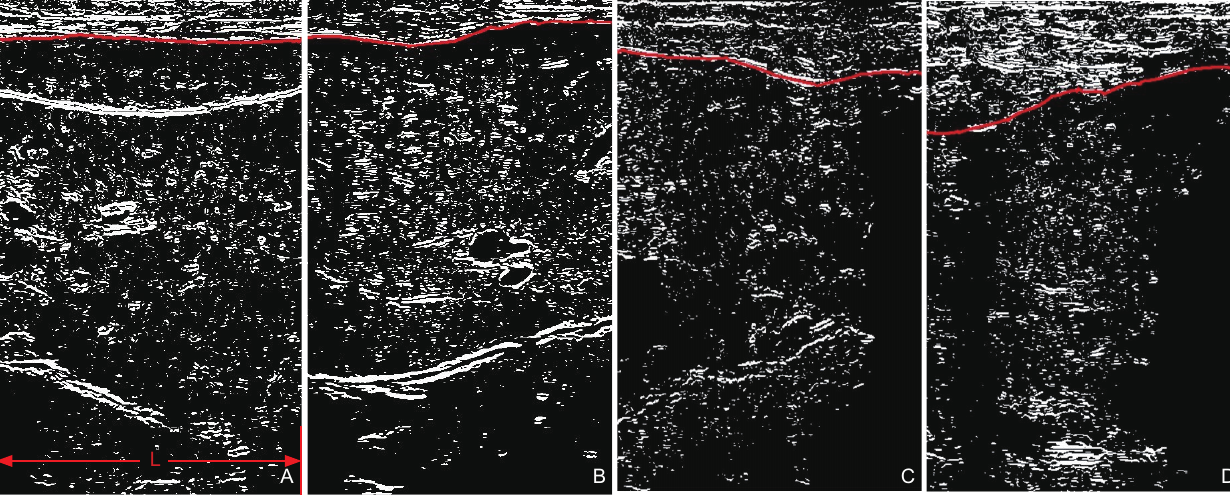
Comparison of smoothness of hepatic capsule: